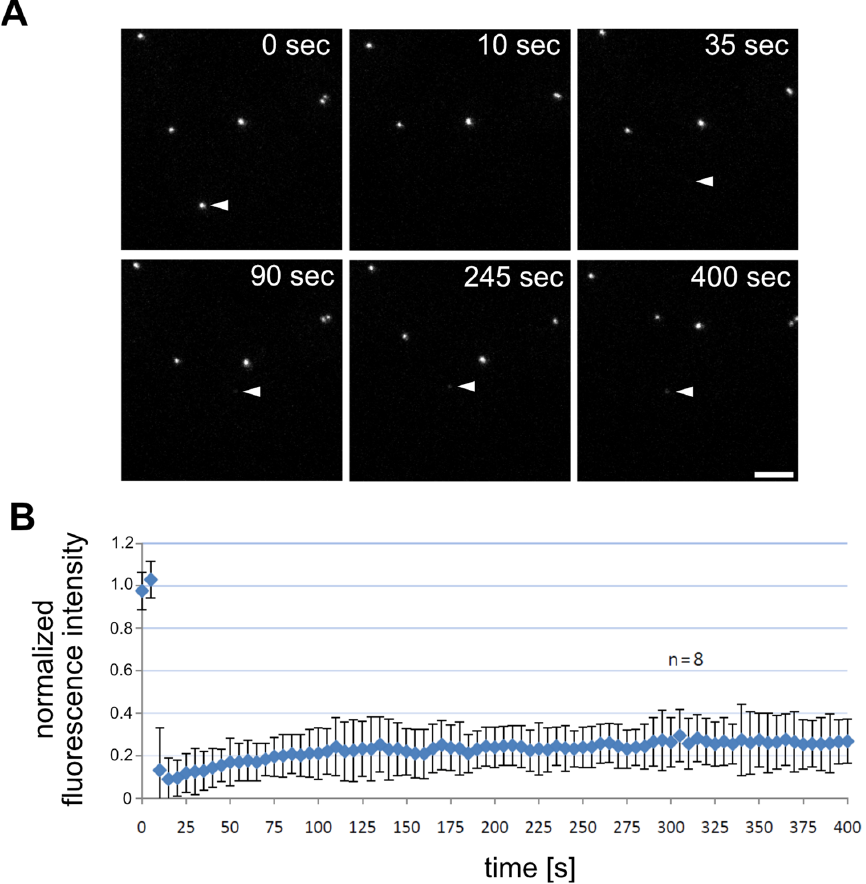
Figure 1. GFP-Cep192 shows hardly any recovery after photobleaching. ( A ) Selected timepoints of a photobleaching experiment (Video S1), Bar = 5 µm. Photobleaching was performed at the filled arrowhead. ( B ) Evaluation of fluorescence recovery of eight individual GFP-Cep192 bleachings.